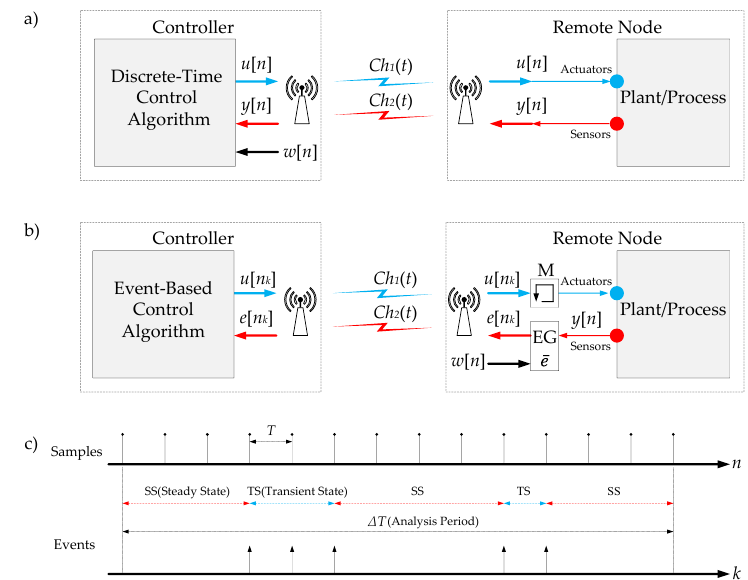
Figure 3. NCS control schemes: ( a ) discrete-time; ( b ) event-based; and ( c ) time diagrams. The samples represent the activity of the discrete-time system; for the event-based solution, the activity is represented by the